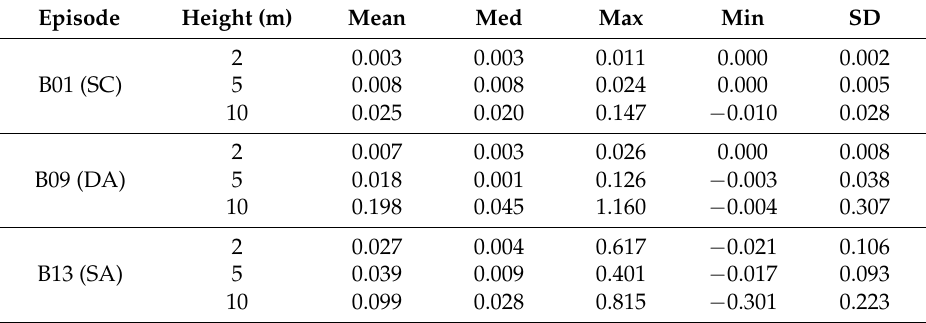
Table 4. The summary statistics of the stability parameter ζ for each bora episode at selected vertical levels.